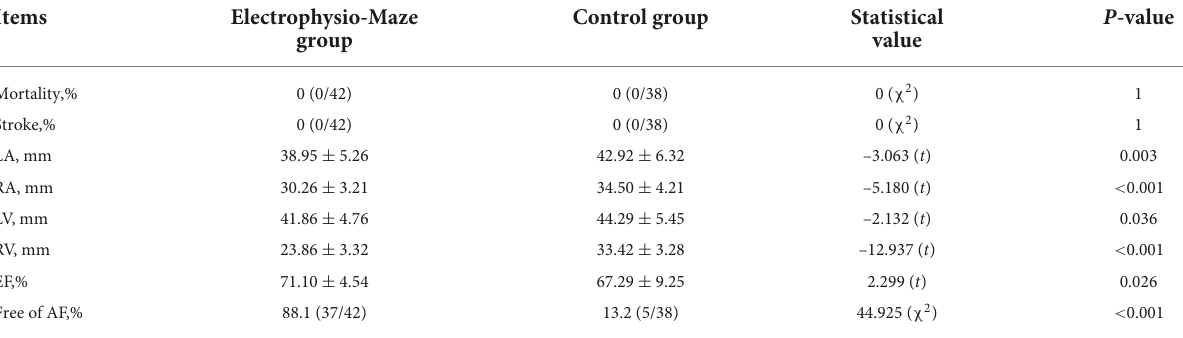
TABLE 4 Comparison of follow-up results after 6 months between two groups.